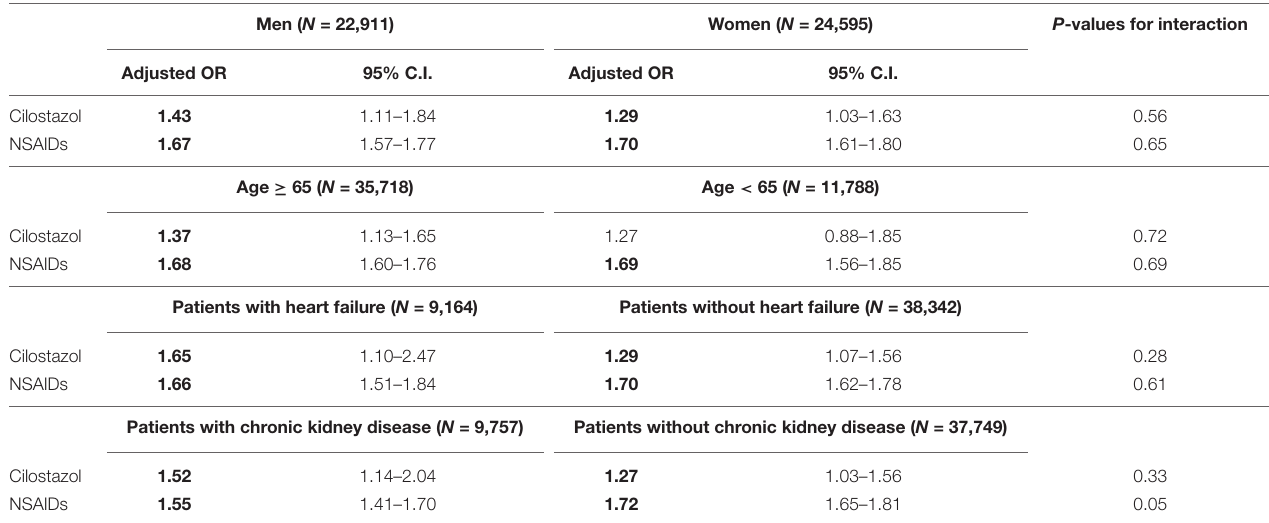
TABLE 5 | Adjusted odds ratio of hospitalized heart failure associated with use of cilostazol and NSAIDs among different subgroups. Men ( N = 22,911) Women ( N = 24,595) P -values for